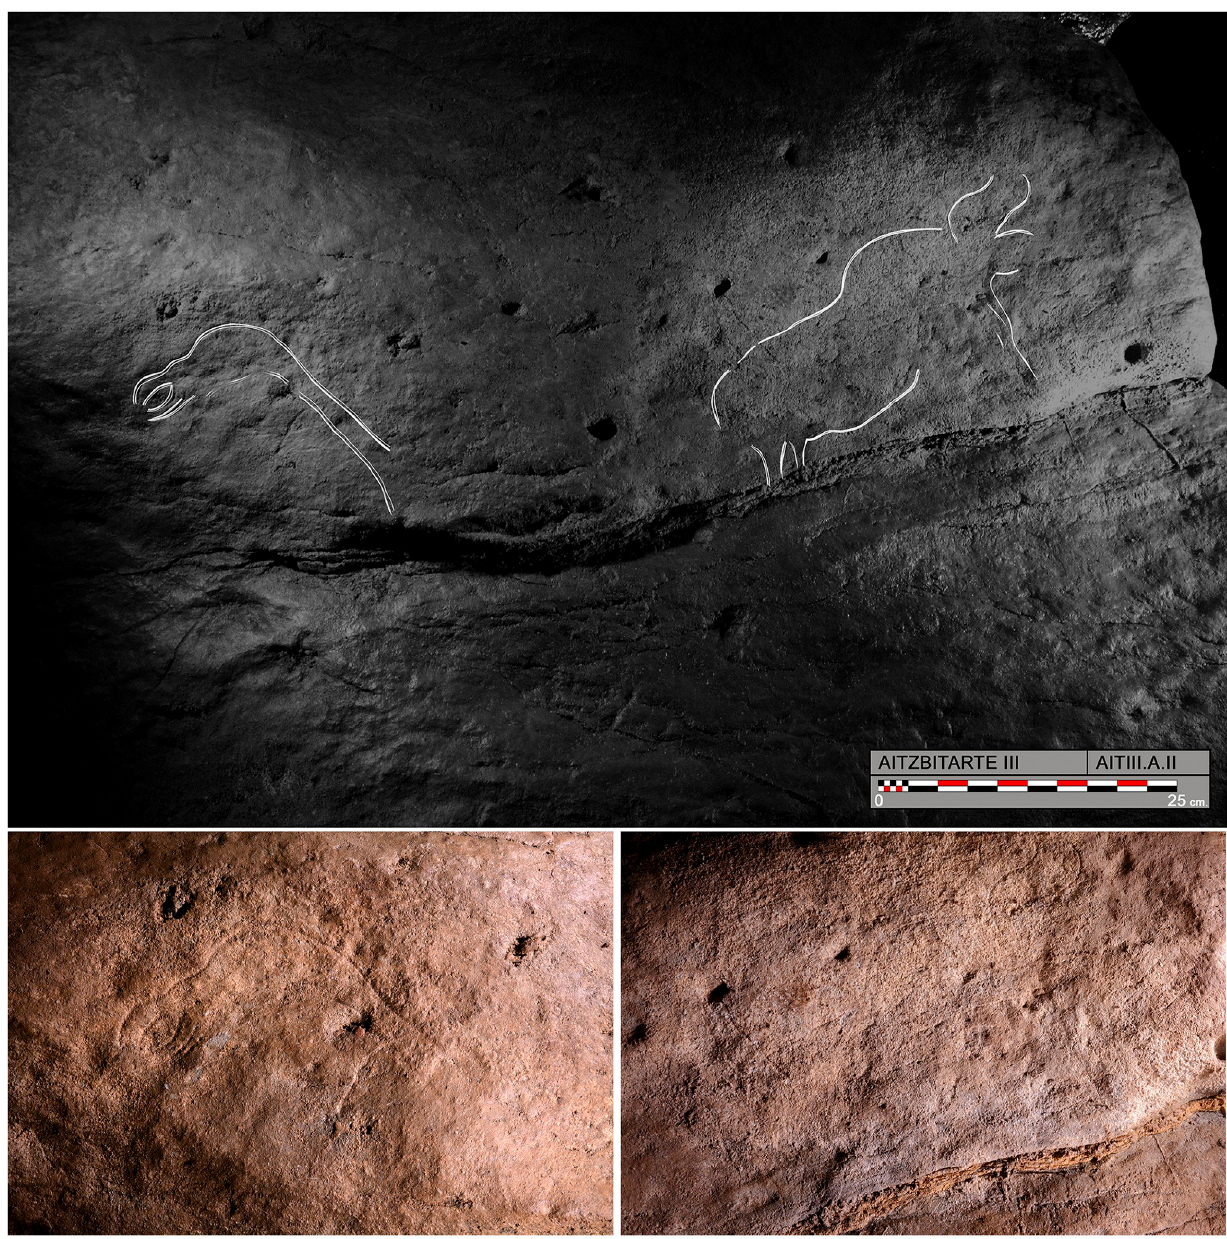
Fig 8. Engravings in the A panel of Aitzbitarte III. Top: Tracing of the panel formed by the bird A.II.2 and the bison A.II.1, engraved on the left wall. Bottom left: Detail of the bird’s head. Bottom right: Detail of the bison (O. Rivero and D. Garate). https://doi.org/10.1371/journal.pone.0240481.g008 A third panel (A.III) is badly damaged, but two horses (A.III.1 and A.IV.3) can be made